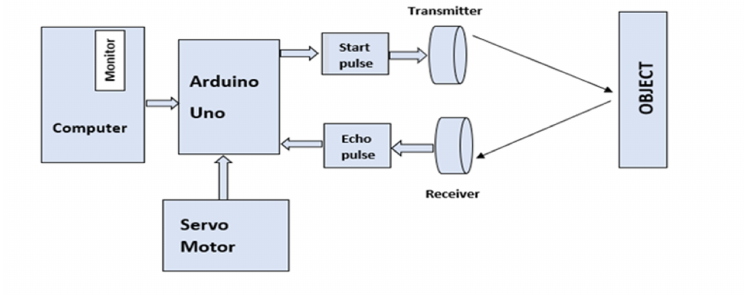
Fig. 5 Block diagram of the working principle of an ultrasonic